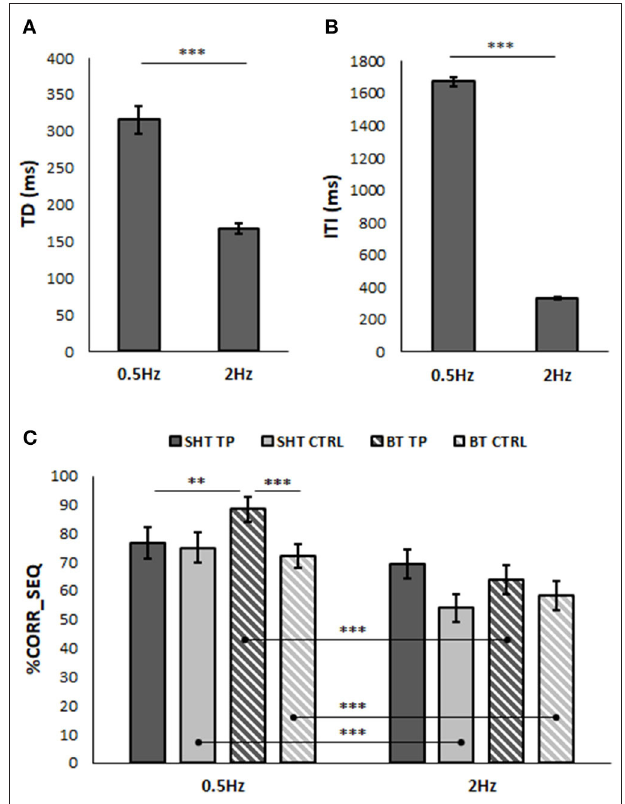
FIGURE 3 | Movement strategy (A,B) and performance accuracy (C) in the movement lateralization test. Mean values of touch duration [TD, (A) ] and inter-tapping interval [ITI, (B) ] when the metronome was set at 0.5 and 2Hz. (C) Representation of mean values of the number of correct movements expressed as a percentage of the total sequence number (%CORR_SEQ) when the metronome was set at 0.5 and 2Hz during single-hand task (SHT) and bimanual task (BT) by tennis players (TP, dark gray) and control participants (CTRL, light gray). Error bars indicate SEM; ** p < 0.01, *** p <